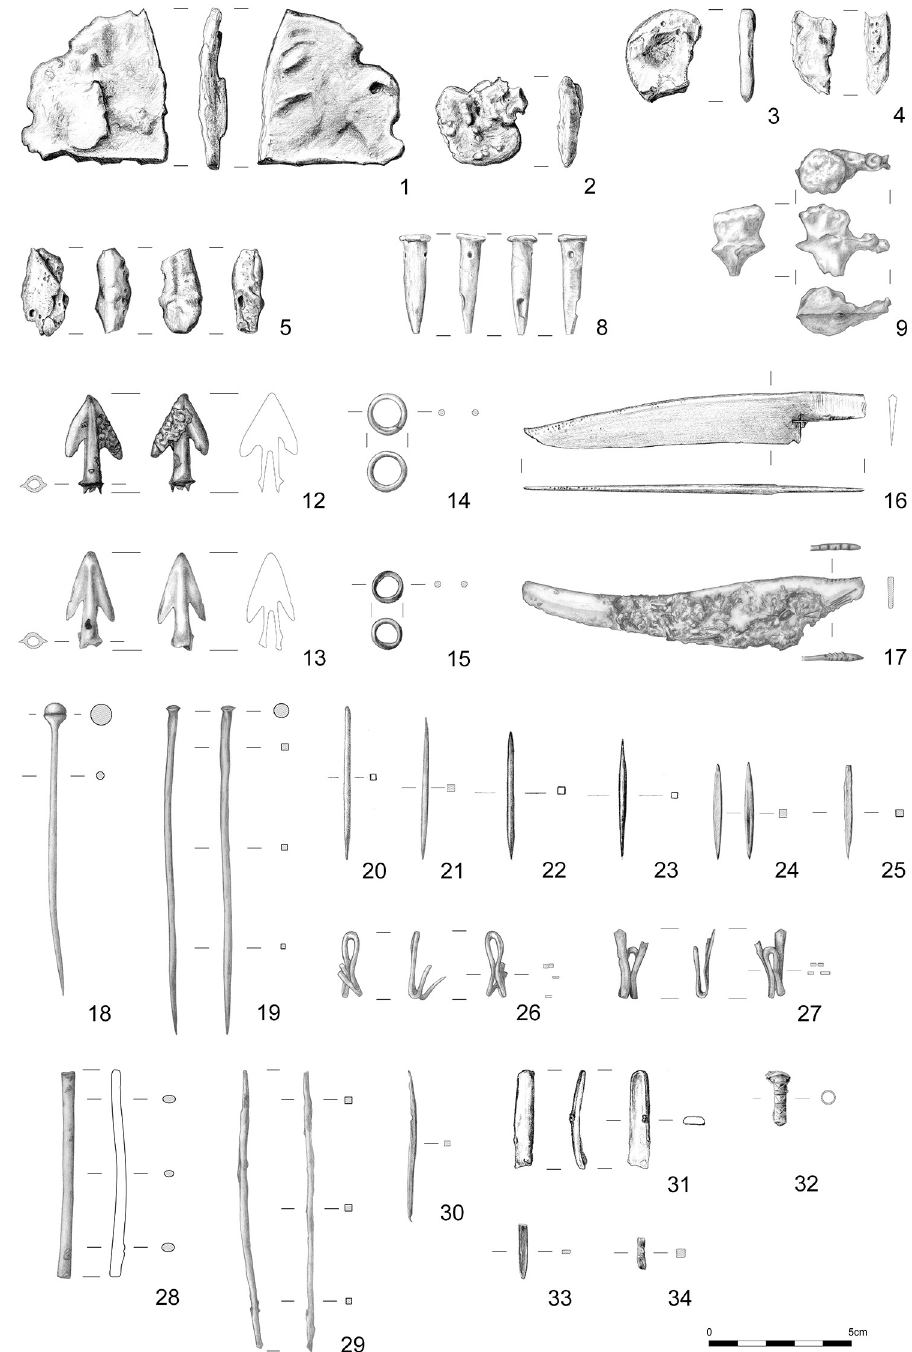
Fig 3. Prigglitz-Gasteil (Lower Austria). Analyses of select copper and copper alloy finds from the Late Bronze Age mining settlement (1–5 casting cakes; 8 casting cone; 9 casting sprue; 12–13 arrowheads; 14–15 rings; 16–17 knives; 18–19 dress pins; 20–25 awls; 26–27 belt clips; 28–29 bar fragments; 30 wire fragment; 31 bracelet fragment; 32 tubelet fragments; 33 tip fragment; 34 bar fragment). Scale 1:2 (drawings by Daniela Fehlmann and Ulrike Weinberger). The numbers correspond to those in the